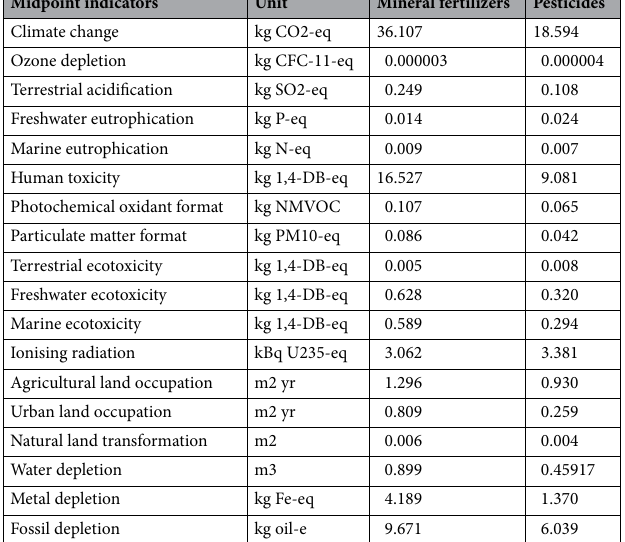
Table 8. Characterization factors of the ReCiPe Midpoint environmental analysis for the used fertilizers and